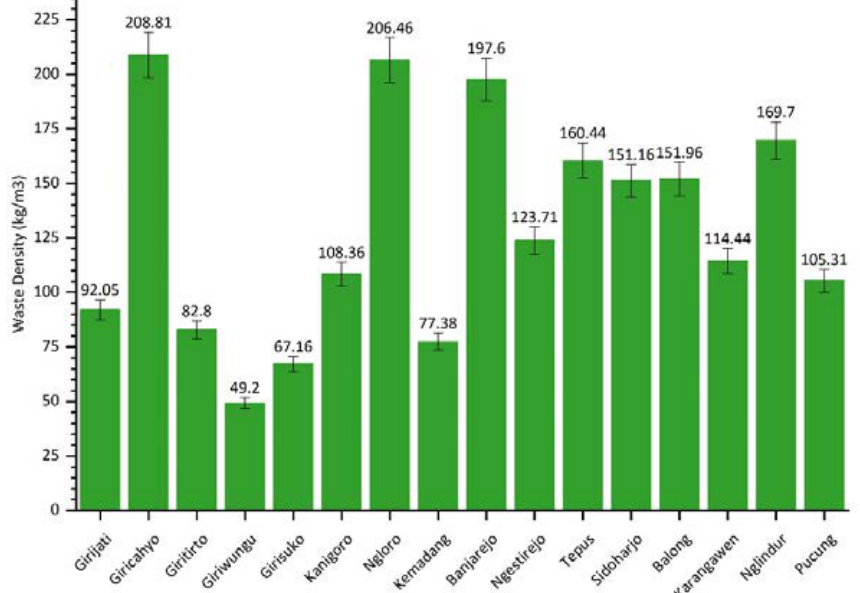
Fig. 8. Waste density based on sample villages